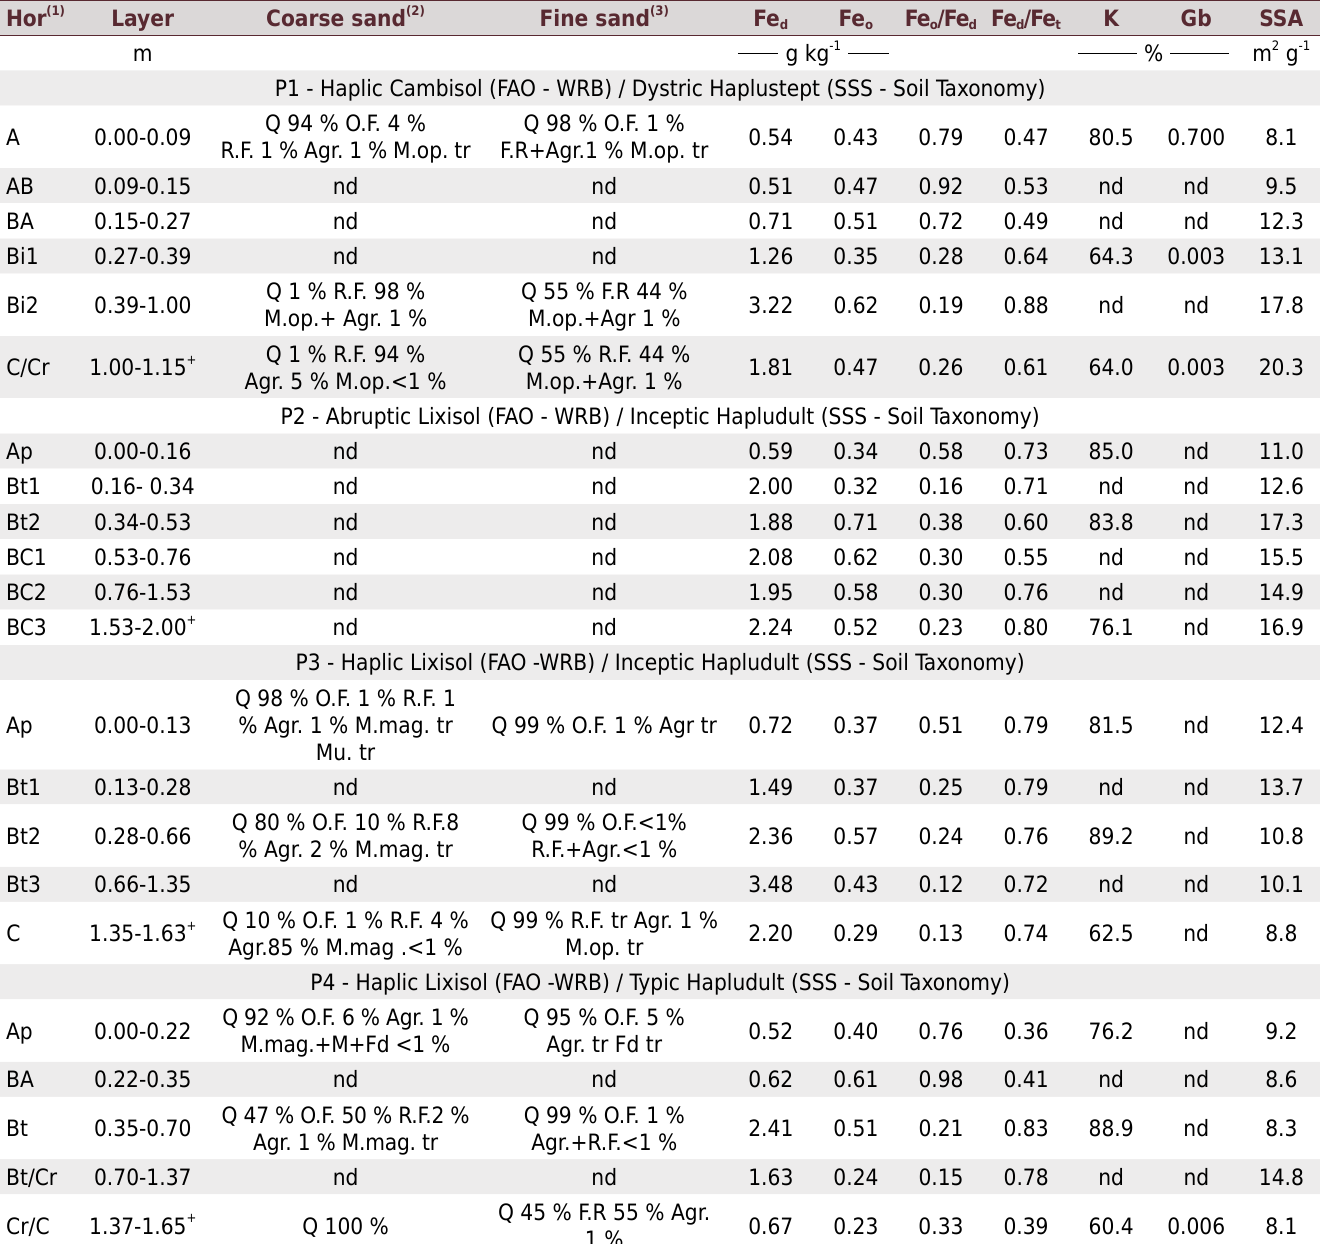
Table 3. Qualitative and quantitative mineralogical composition of the coarse sand and fine sand, Fe - Extracted by DCB (Fe d ) and OAA (Fe o ), quantification of kaolinite and gibbsite in the clay fraction, and specific surface area of clay minerals of soils in a rhyolite toposequence in the Ipojuca formation, Sirinhaém, PE,